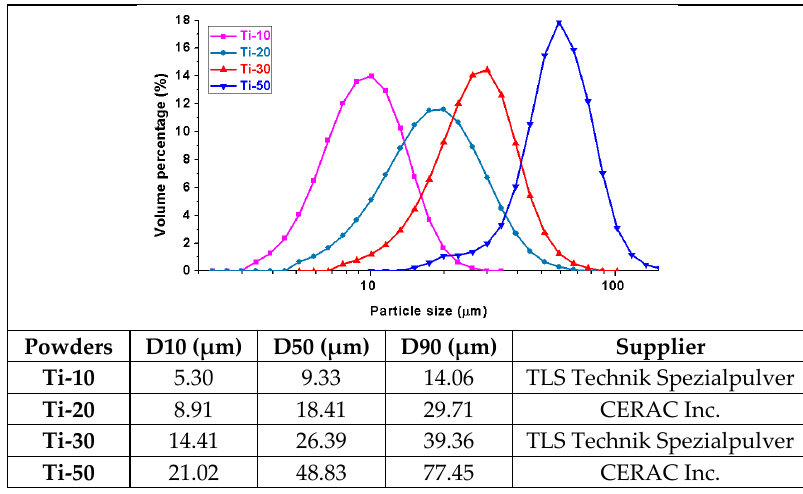
Figure 3. The particle-size distribution of the four types of Ti raw powders.